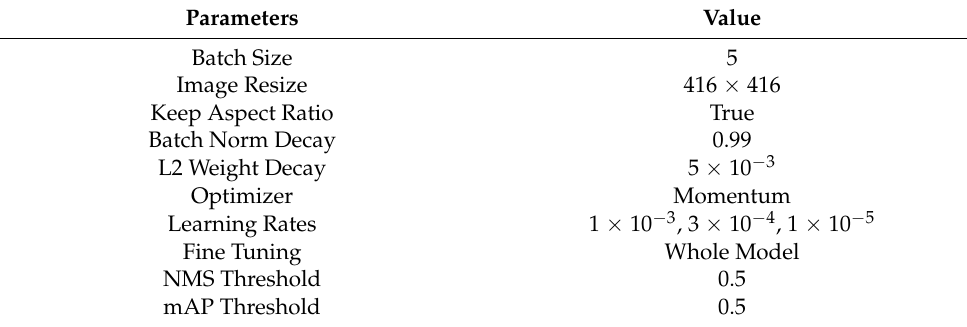
Table 1. YOLO parameters during